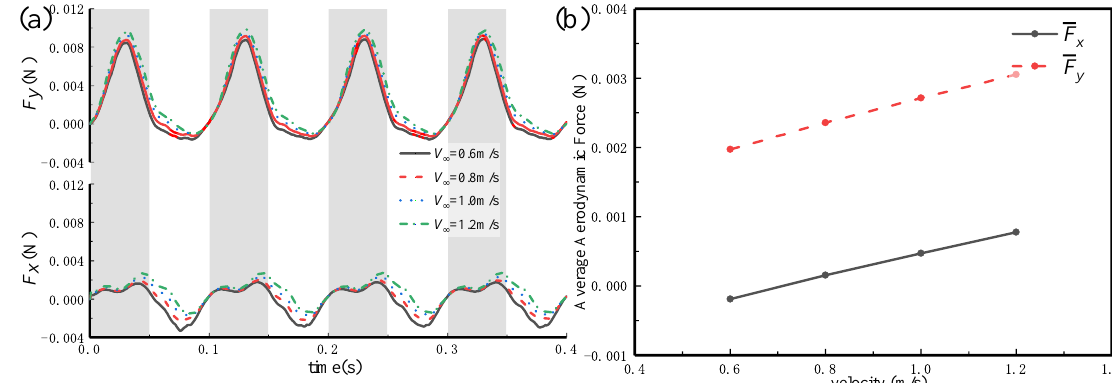
Figure 9. ( a ) The instantaneous aerodynamic forces of the butterfly accompanied by the change of V ∞ in four flapping cycles; and ( b ) the average aerodynamic forces at different incoming flow